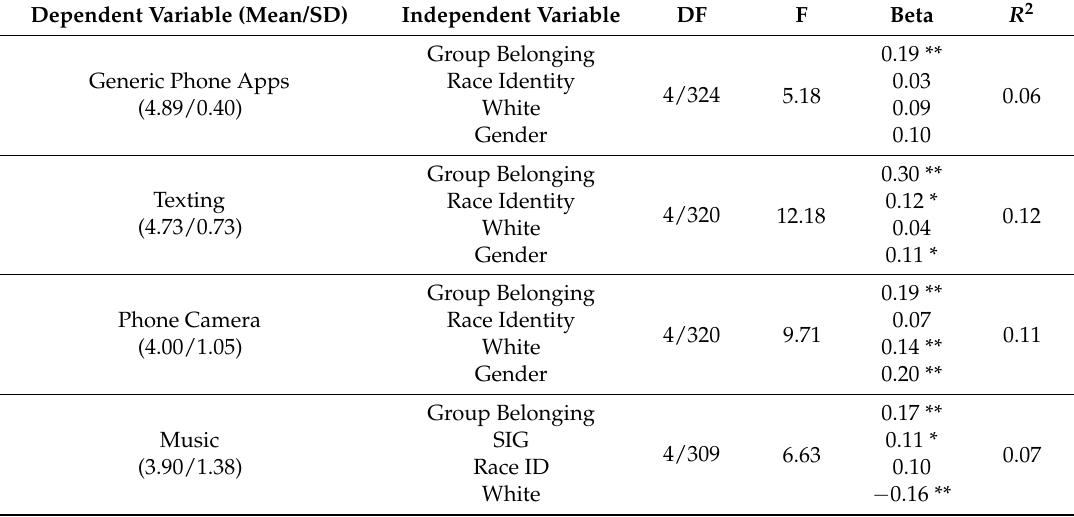
Table 3. Regression Analyses: Predictors of Generic Phone App Use, Texting, and Phone